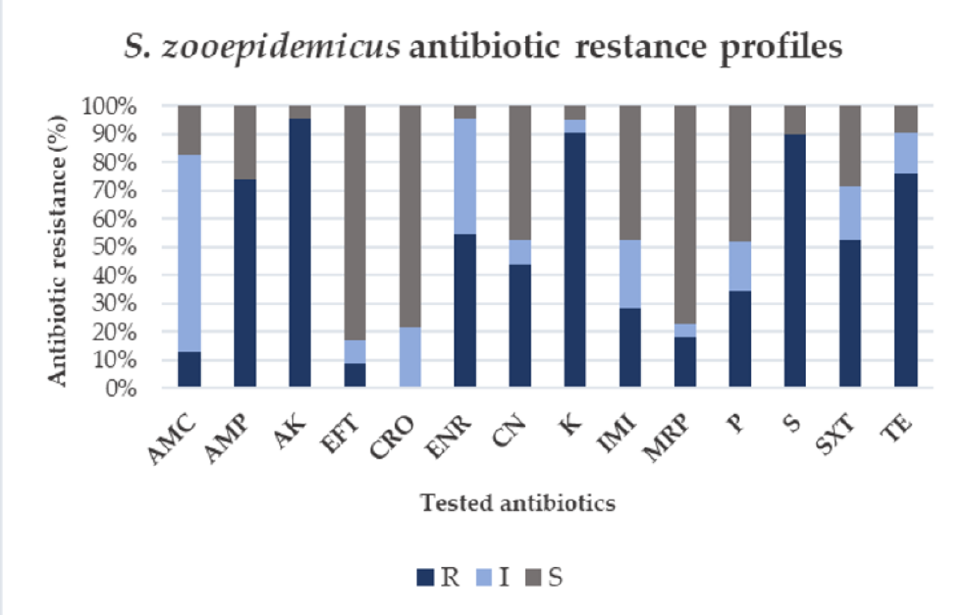
Figure 1. Antibiotic resistance profiles of 23 S. zooepidemicus isolates. The isolates were classified as resistant (R), intermediate (I), or susceptible (S) to tested antibiotics. Antibiotics: AMC: amoxicillin- clavulanate; AMP: ampicillin; AK: amikacin; EFT: ceftiofur; CRO: ceftriaxone; ENR: enrofloxacin; CN: gentamicin; K: kanamycin; IMI: imipenem; MRP: meropenem; P: penicillin; S: streptomycin; SXT: sulfamethoxazole-trimethoprim; TE: tetracycline. Since 22 strains were tested to ENR, 21 to K, 22 to IMI, 22 to MRP, 20 to S, 21 to SXT and 21 to TE, a maximum error of 4.3% (1/23 × 100 = 4.3%) was